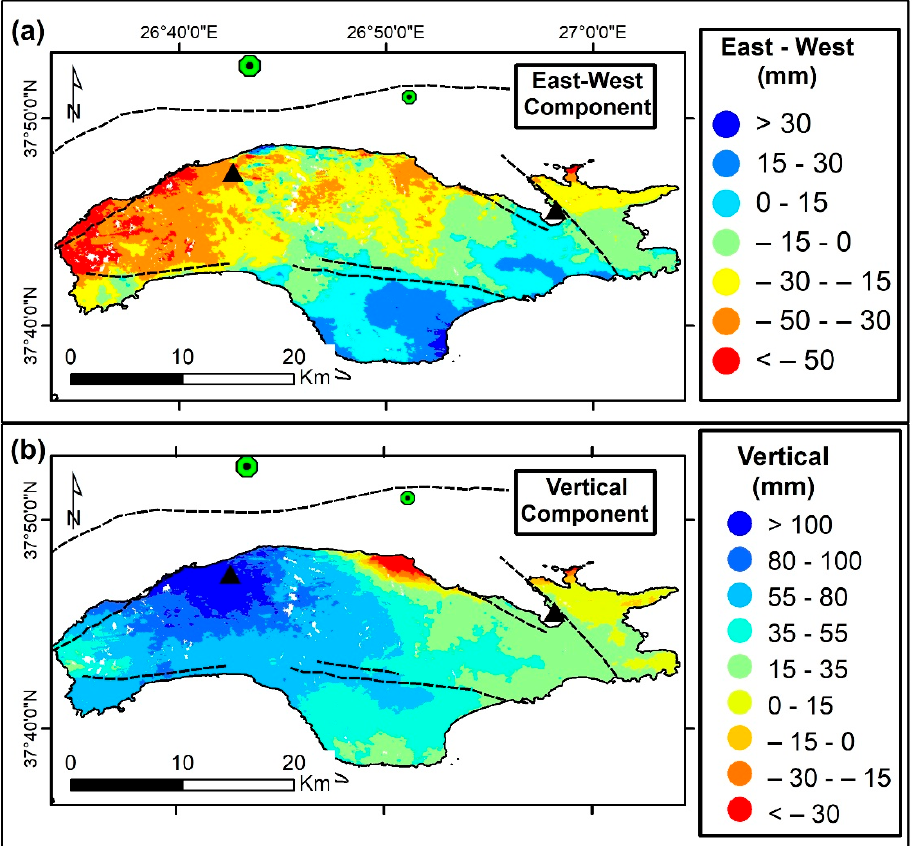
Figure 8. Multi-geometry data decomposition of the calibrated unwrapped interferometric displace- ments maps for the ( a ) E–W and ( b ) vertical co-seismic components. Negative values on the E–W component represent westward motion. Black triangles mark the two GNSS stations on Samos (SAMO to the west and SAMU to the east).